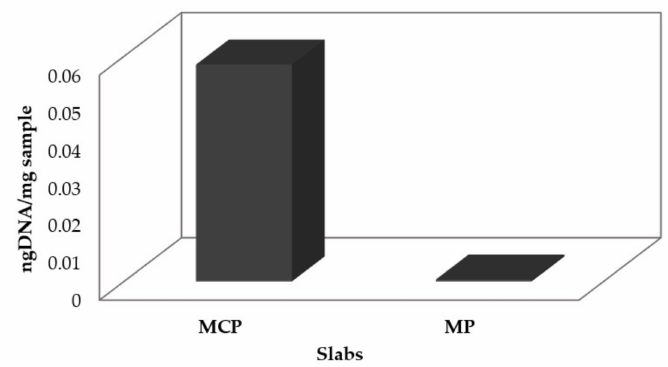
Figure 7. DNA quantification of marble slabs from the simulation assays and the percentage of fungi